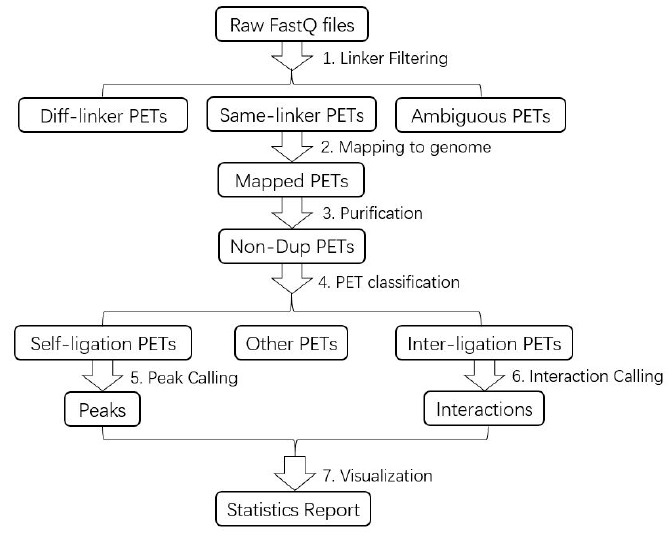
Figure 3. Flowchart of ChIA-PET Tool V3 for ChIA-PET data analysis.